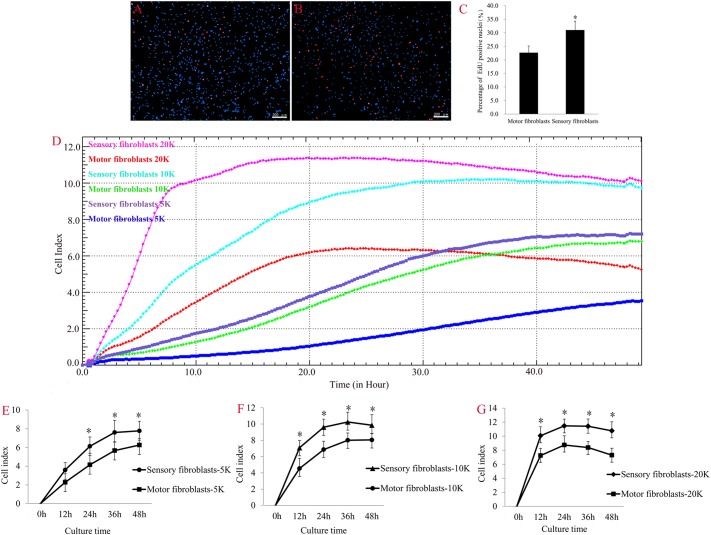
The merge of EdU staining (red) and Hoechst 33342 staining (blue) for cultured motor (A) and sensory (B) fibroblasts, in which scale bar is 200 μm. (C) The histogram showing the percentage of EdU-positive nuclei in motor and sensory fibroblasts. p = 0.041, unpaired t-test, n = 9 rats. (D) Proliferation capacity of motor and sensory fibroblasts in three different cell density of 5K, 10K, 20K continuously monitored by RTCA for 48 h. Quantification of cell proliferation index of cultured sensory and motor fibroblasts in three different cell density of 5K (E), 10K (F), 20K (G). ∗p < 0.05 vs. motor fibroblasts, unpaired t-test, n = 14–15 rats.